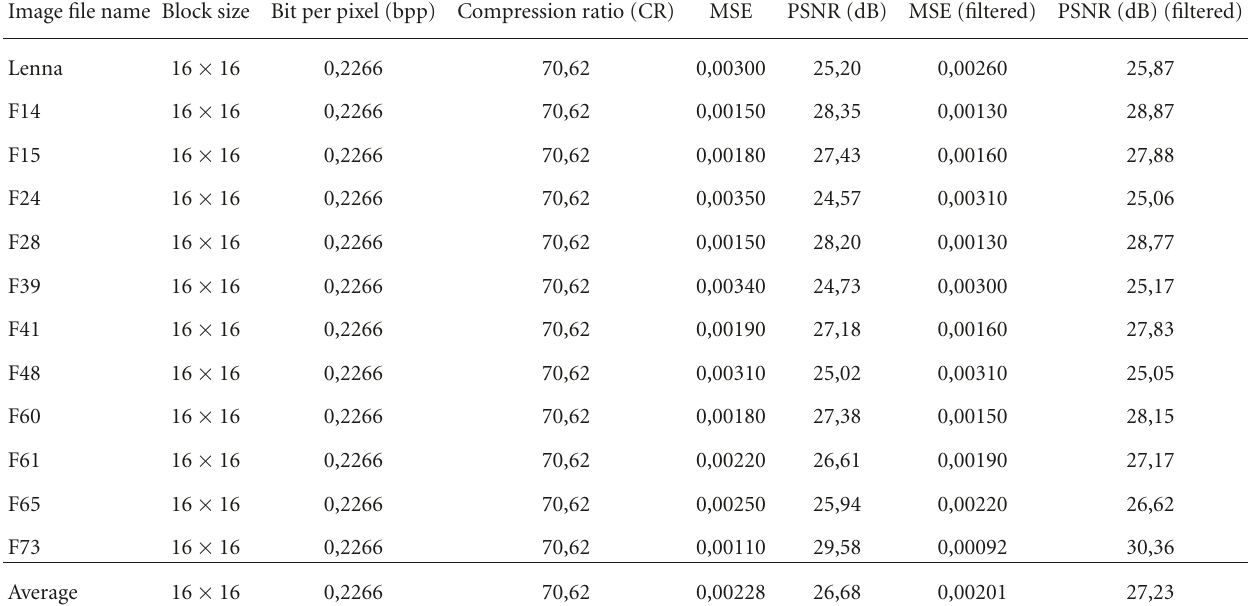
Table 10: Evaluation results of the second group of experiments.